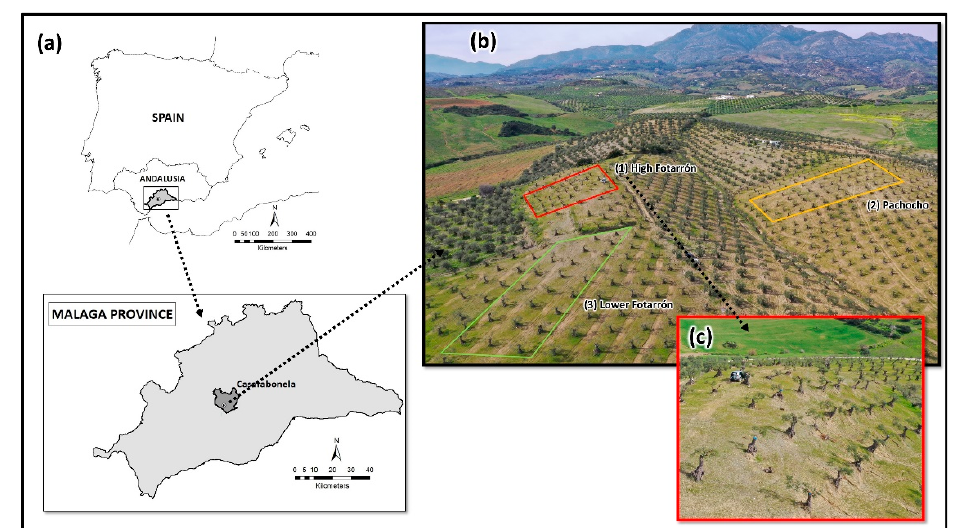
Figure A1. Location map of the study site in the province of Malaga, Spain ( a ), general view of the topography of the three study plots (high, medium, and low) ( b , c ).